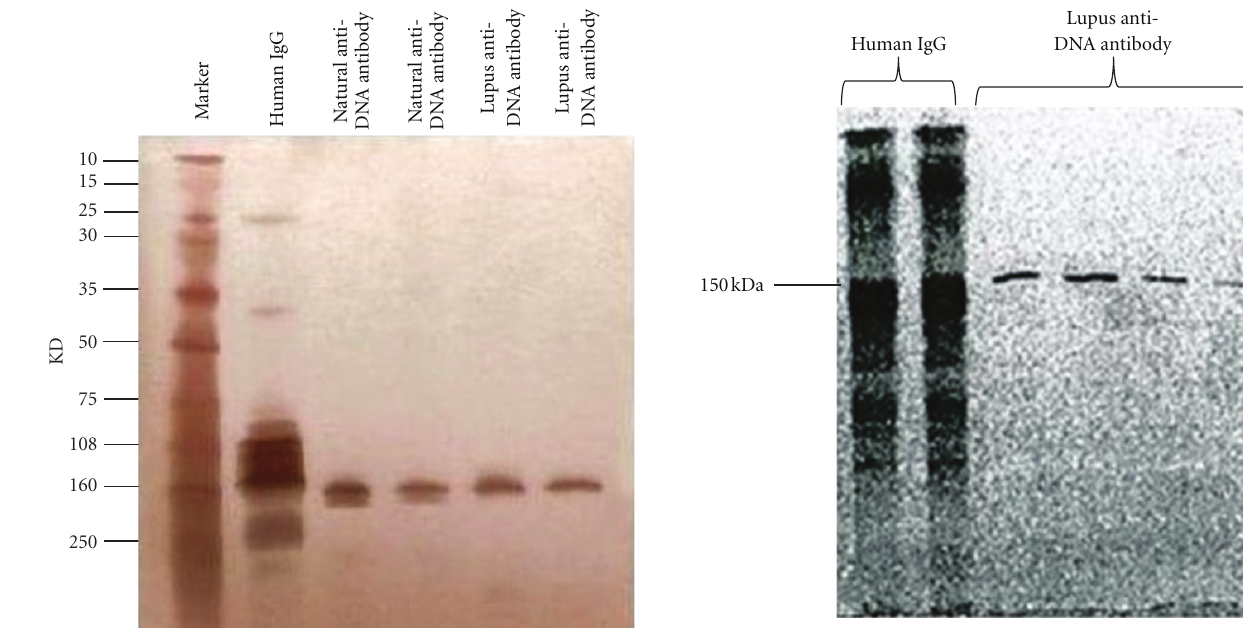
Figure 1: Electrophoretic analysis of the purity of anti-DNA anti- body isolated via two-step magnetic bead method. ∗ Purified anti- DNA antibodies from normal healthy serum donors and SLE patients are detected by nonreducing SDS-PAGE and silver staining.